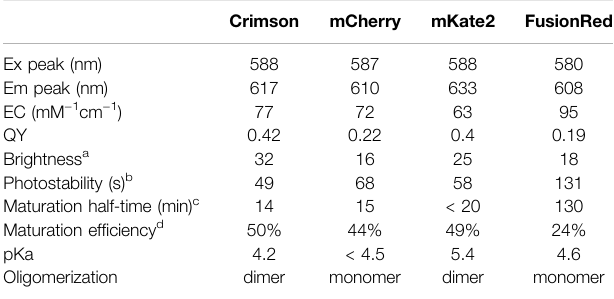
TABLE 1 | Key characteristics of red fl uorescent proteins with excitation peak at 580 – 590 nm. Crimson mCherry mKate2